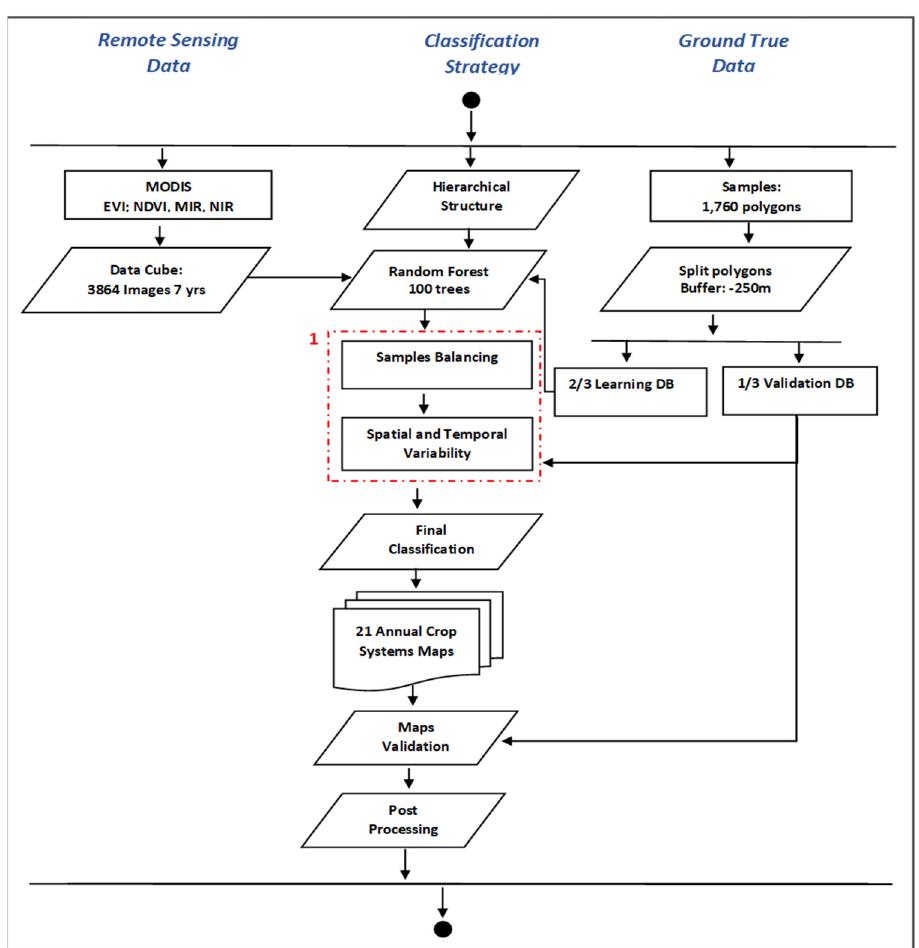
Figure 4. Flowchart presenting the main classification strategy issues. 1 Methodological issues: Sam- ples balancing strategy assessment; Spatial variability assessment; Temporal variability assessment.